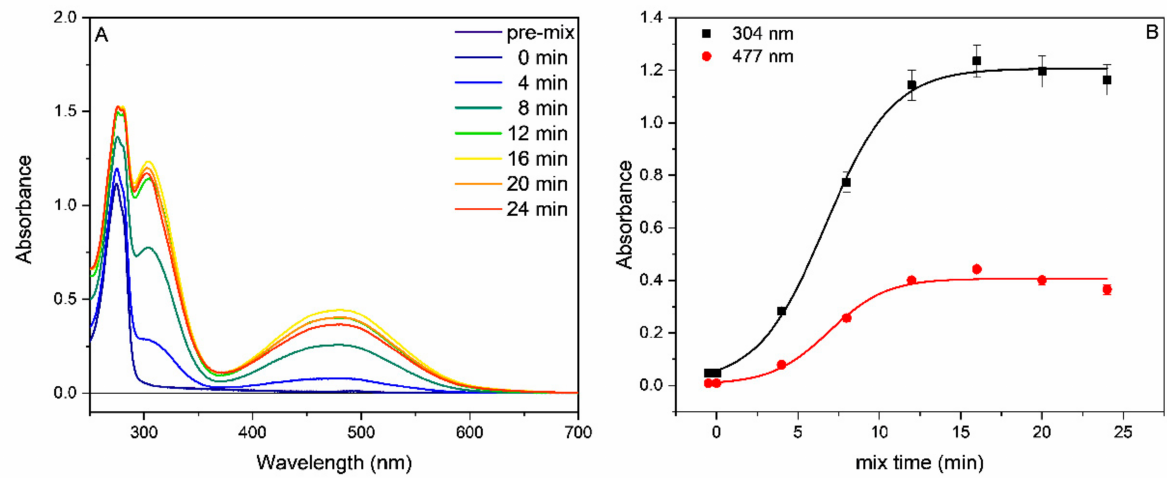
Figure 2. ( A ) UV-Vis spectra of L -Tyr (2 mM) in 20 mM phosphate buffer, pH 7.4, pre-mix and after mix with the tyrosinase solution (0.12 mg/mL) at different time of incubation (indicated). ( B ) Time-course of tyrosine oxidation by the tyrosinase/O 2 oxidizing system. Data are the average of three replicates and the error is less than